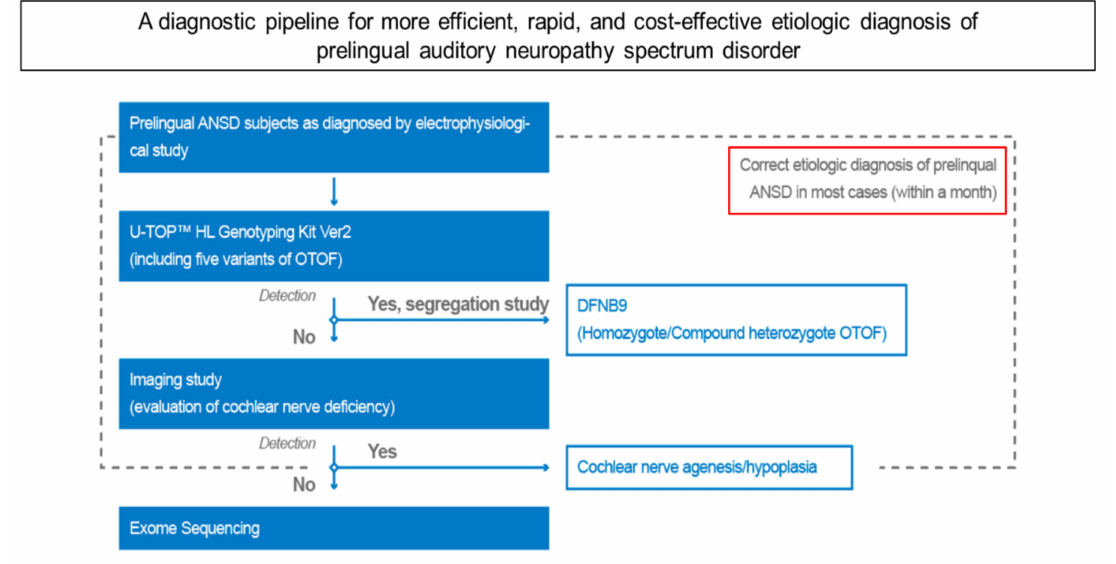
Figure 3. A diagnostic pipeline for more e ffi cient, rapid, and cost-e ff ective etiologic diagnosis of